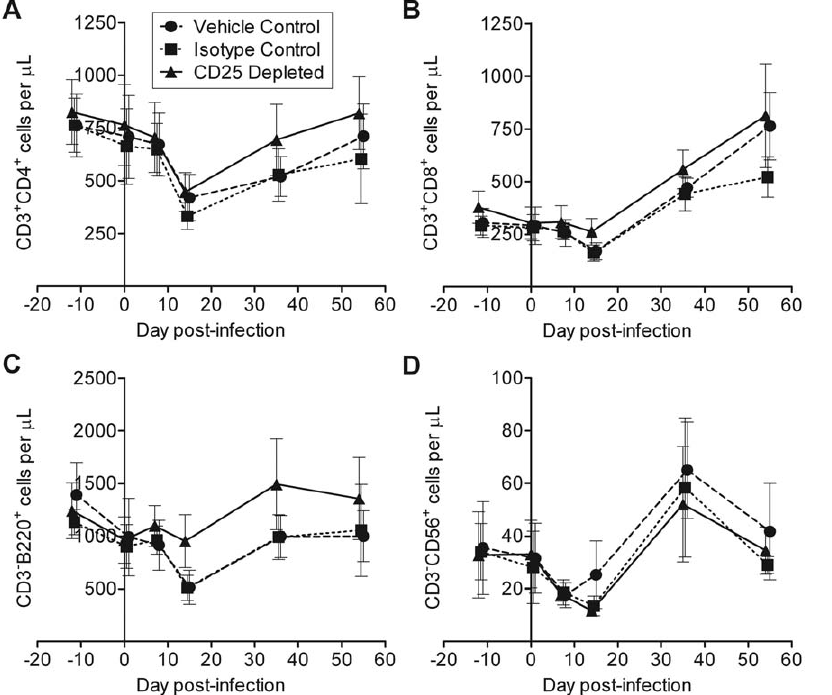
Figure 4. Peripheral lymphocyte dynamics during acute FIV-C36 infection are not altered by anti-CD25 mAb treatment. Absolute numbers of (A) CD3 + CD4 + , (B) CD3 + CD8 + , (C) CD3 2 B220 + (B cells), and (D) CD3 2 CD56 + (NK cells) lymphocytes in the periphery were quantified on days 2 12, 0, 7, 14, 35, and 54 p.i. based on percentages obtained by flow cytometry and absolute number of peripheral lymphocytes. Mean 6 SEM is shown